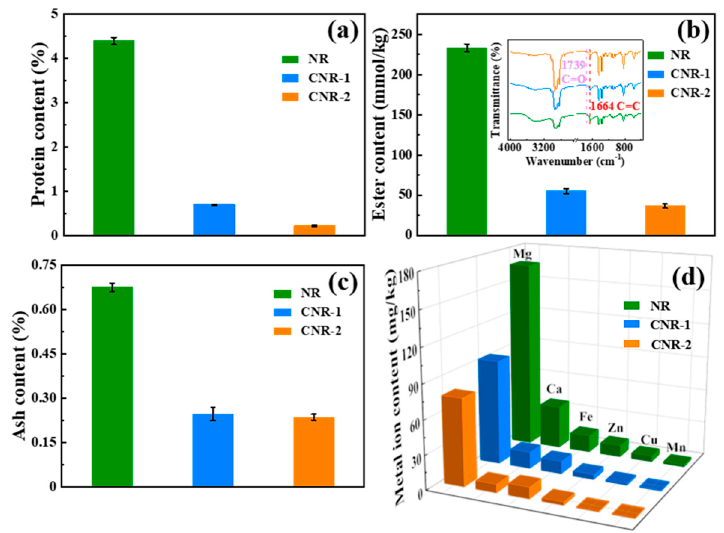
Figure 1. The variation of protein content ( a ), ester content ( b ), ash content ( c ), and metal ion content ( d ) in natural rubber (NR) before and after centrifugation.